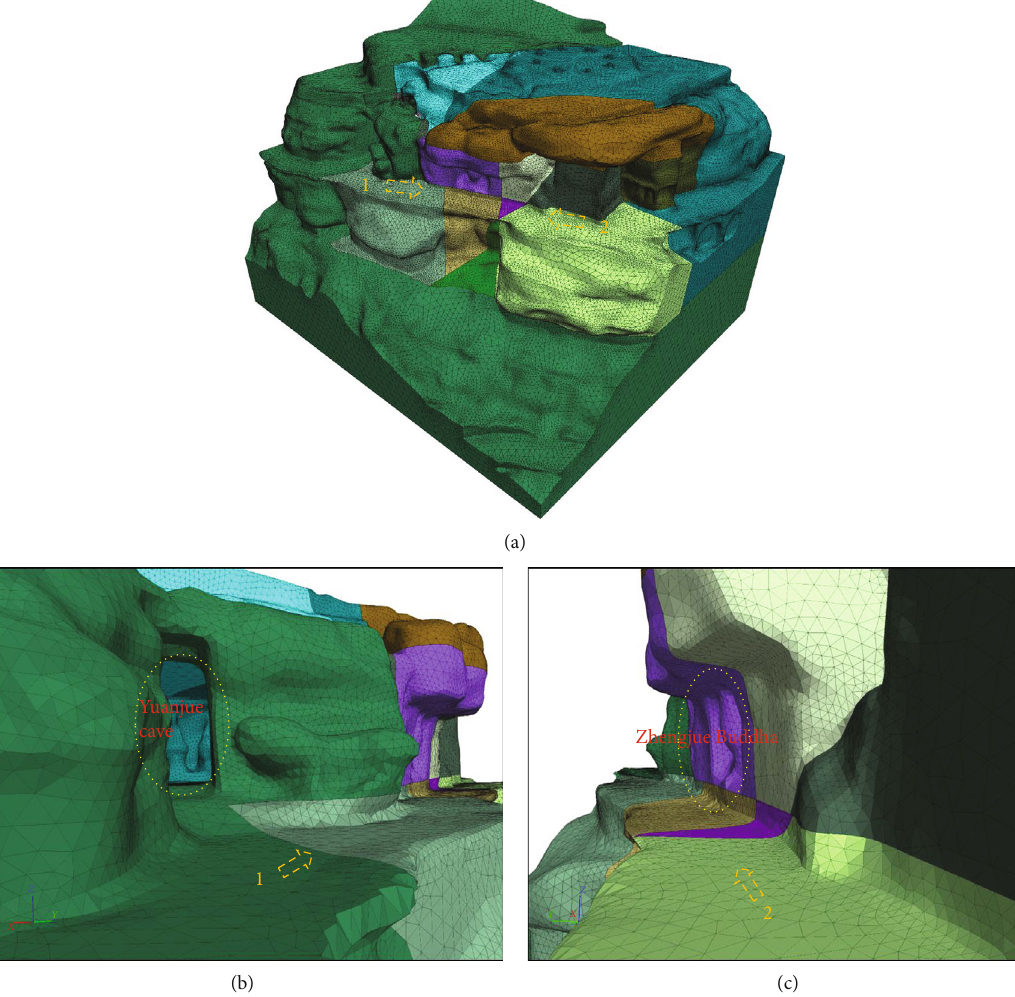
Figure 3: Computation model of rock mass and fi ssure: (a) three-dimensional geological model of the South Cli ff of Big Buddha Bay; (b) east view of the South Cli ff visitor passage; (c) west view of the South Cli ff visitor